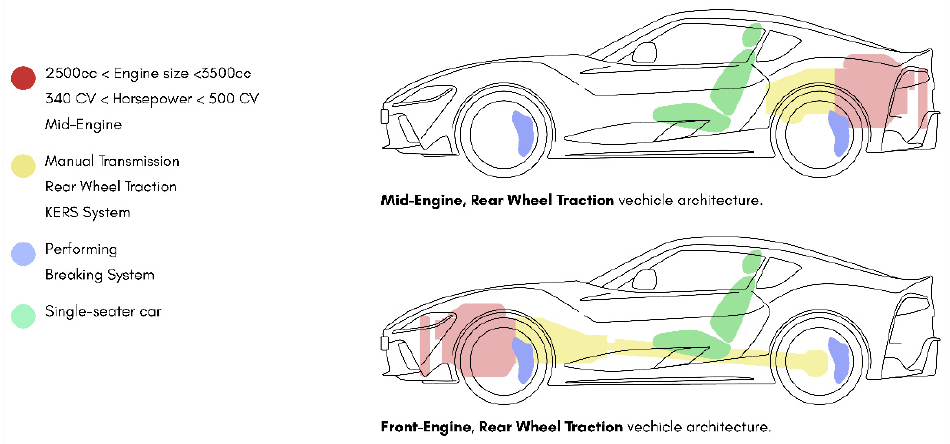
Figure 15. Product Architecture and comparison between different engine configurations.